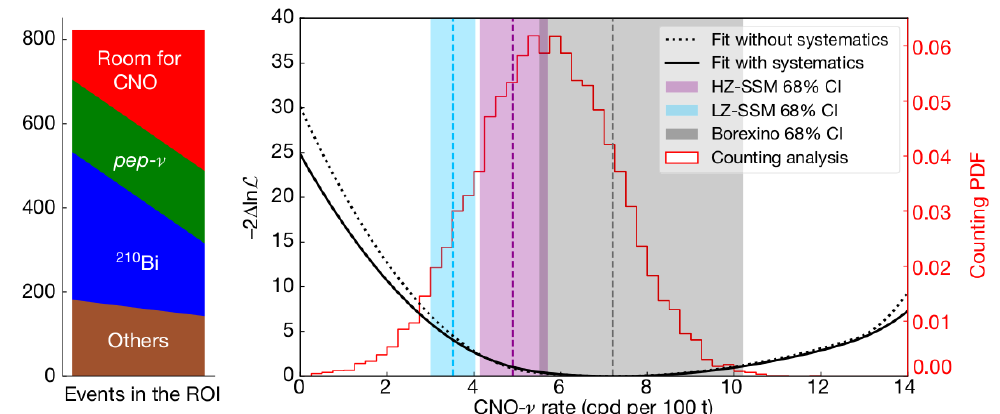
Figure 11. Summary of CNO counting and spectral analysis results. Left, counting analysis bar chart. Right, CNO neutrino rate negative log-likelihood (ln analysis and models predictions. From